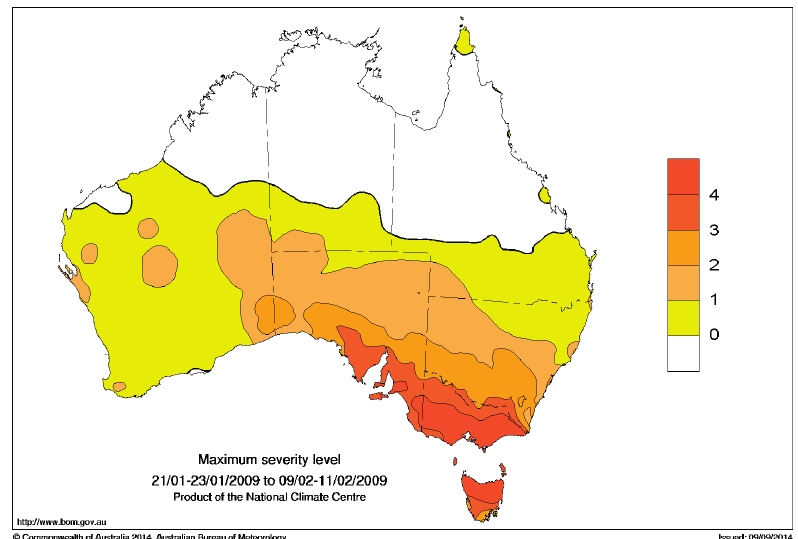
Figure 17. As per Figure 16 but expressed in multiples of the severity threshold. Yellow denotes a low-intensity heatwave (ratios between 0 and 1). Dark orange colours denote an extreme heatwave (ratios of 3 and higher). Ratios between 1 and 3 denote a severe but not extreme heatwave.